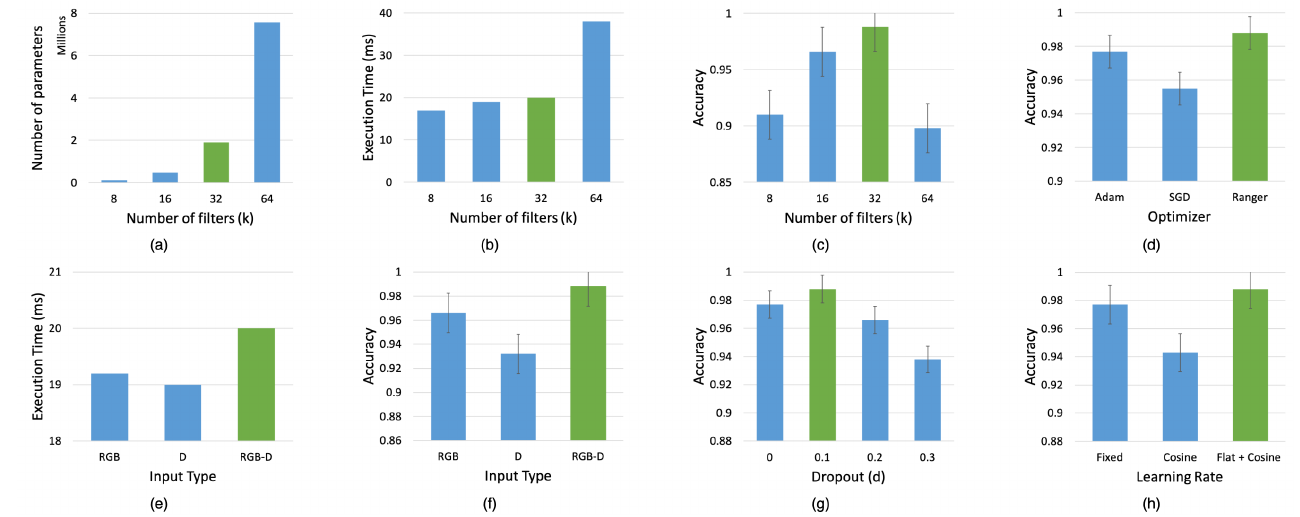
Figure 10. Ablation study results for GR-Convnet by training on different filter sizes (k), input channels (n), dropout (d), optimizers and learning rates. The model is evaluated using the 25% IoU metric against the Cornell dataset. Green indicates the selected parameter. ( a – c ) Number of parameters, execution time and accuracy for different number of filters. ( d ) Grasp prediction accuracy for different optimizers. ( e – f ) Execution time and prediction accuracy of the network for different modalities. ( g ) Grasp prediction accuracy for different dropout percentage. ( h ) Grasp prediction accuracy for different learning